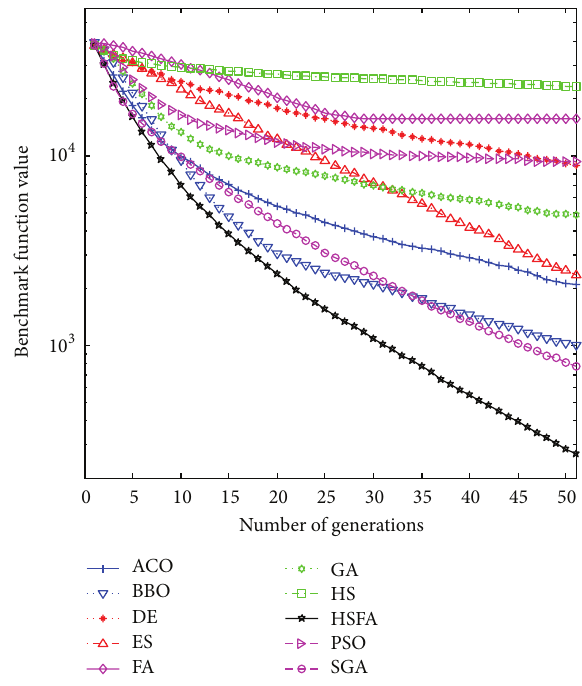
Figure 4: Performance comparison for the F33 step